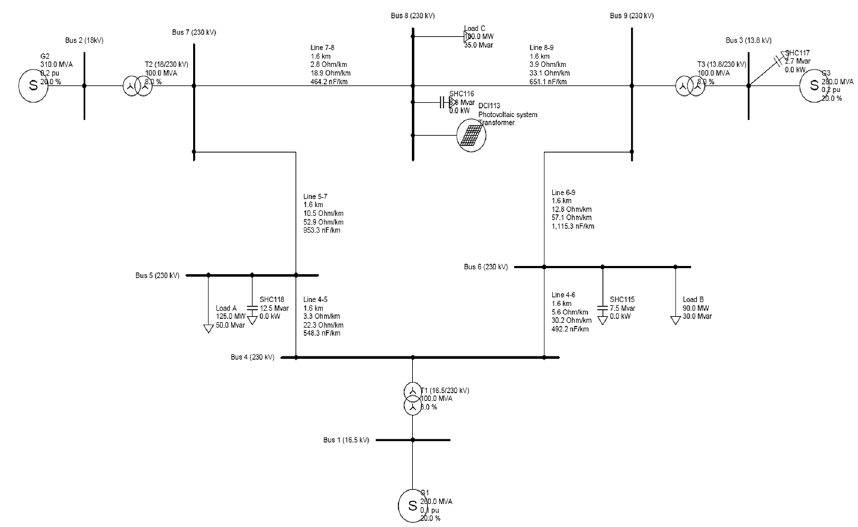
Fig. 2 Configuration of the optimised placement of capacitors for solar bus connected to bus 8 of the IEEE-9 bus